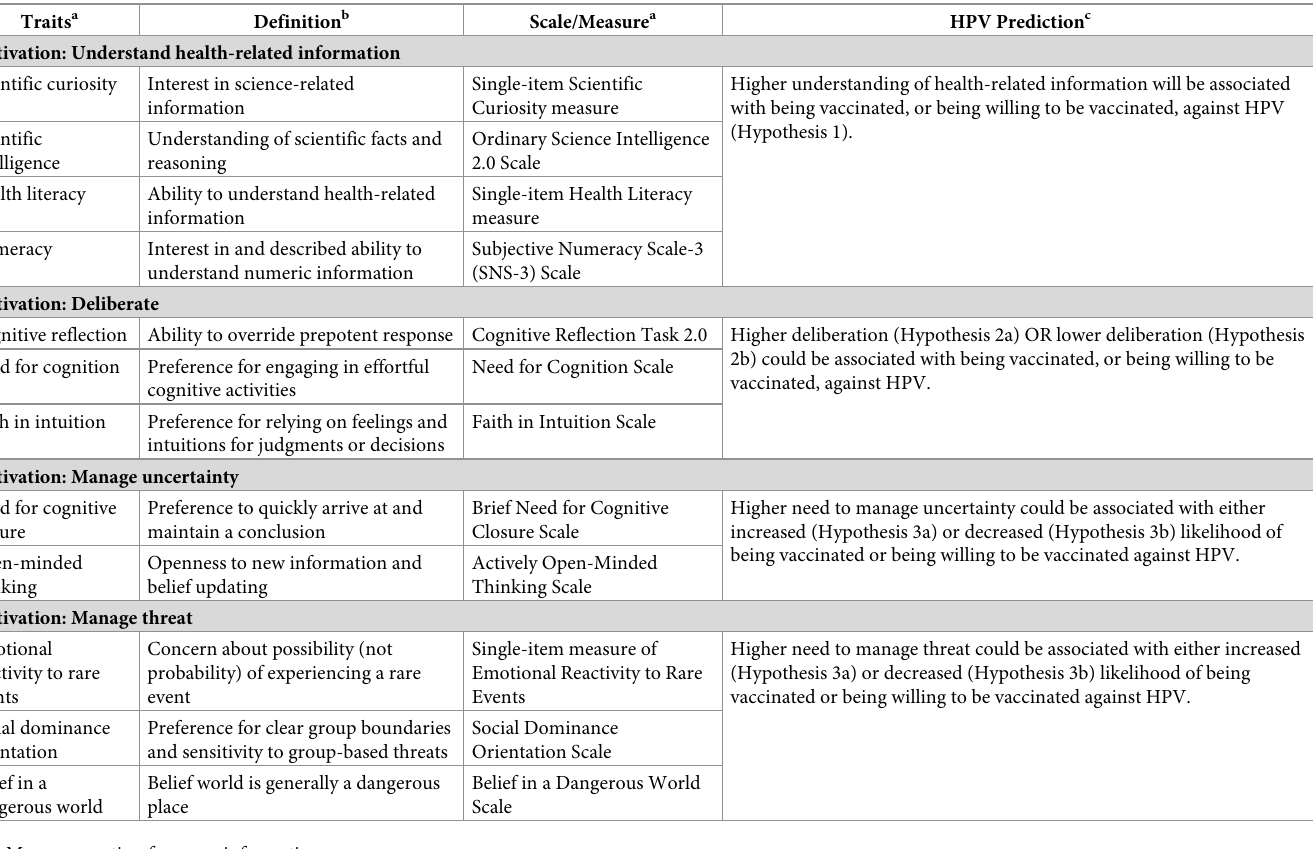
Table 1. Psychological traits, definitions, scales/measures, and predictions for each type of